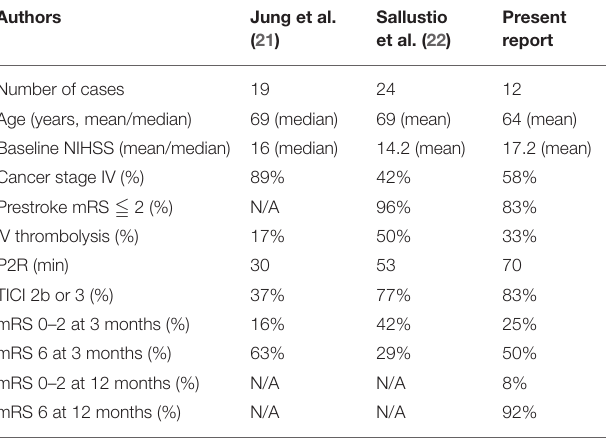
TABLE 3 | Previous results of thrombectomy for stroke patient with malignancy. Authors Jung et al.